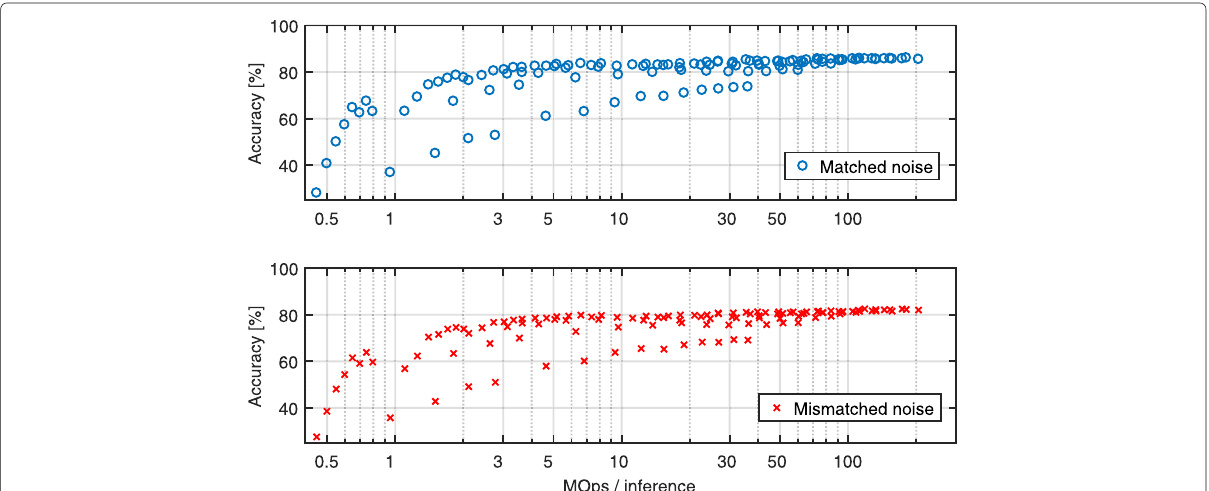
Fig. 7 Average accuracy in the range between 0 and 20 dB SNR of all trained networks in hyper-parameter search as a function of the number of operations per